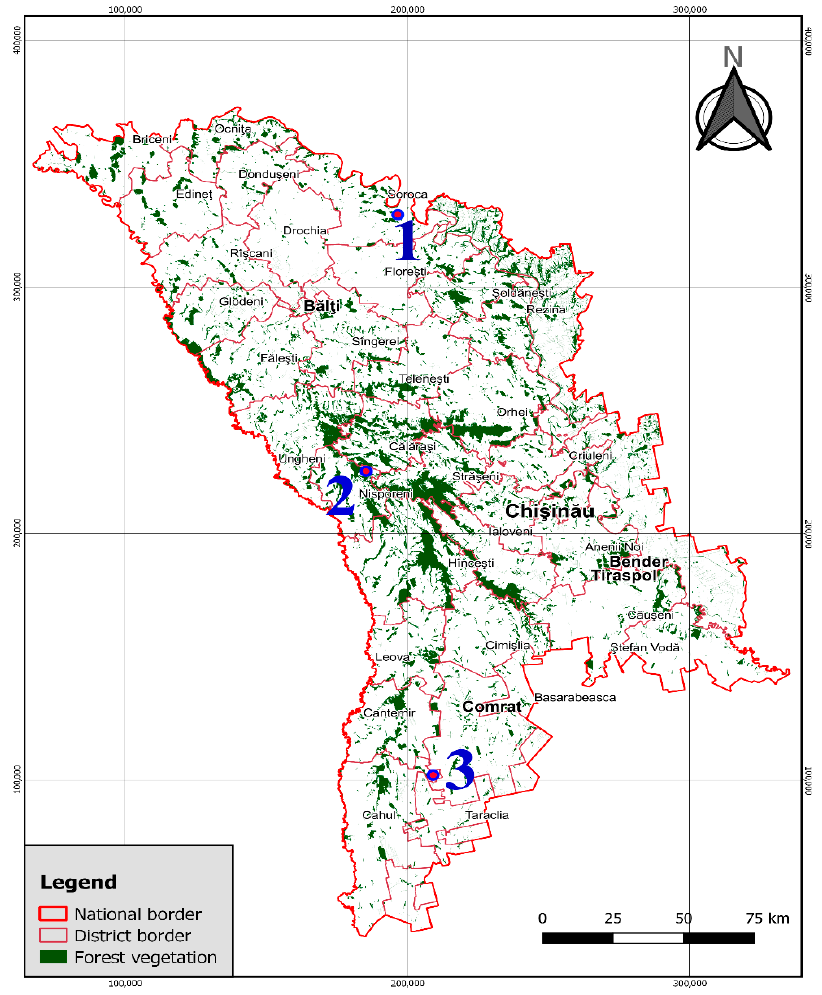
Figure 3. Eco-geographical position of the three selected localities considered for this study (1— Alexandru cel Bun, 2—Ciore ș ti, 3—Borceag). (1—Alexandru cel Bun, 2—Ciores ti, ,